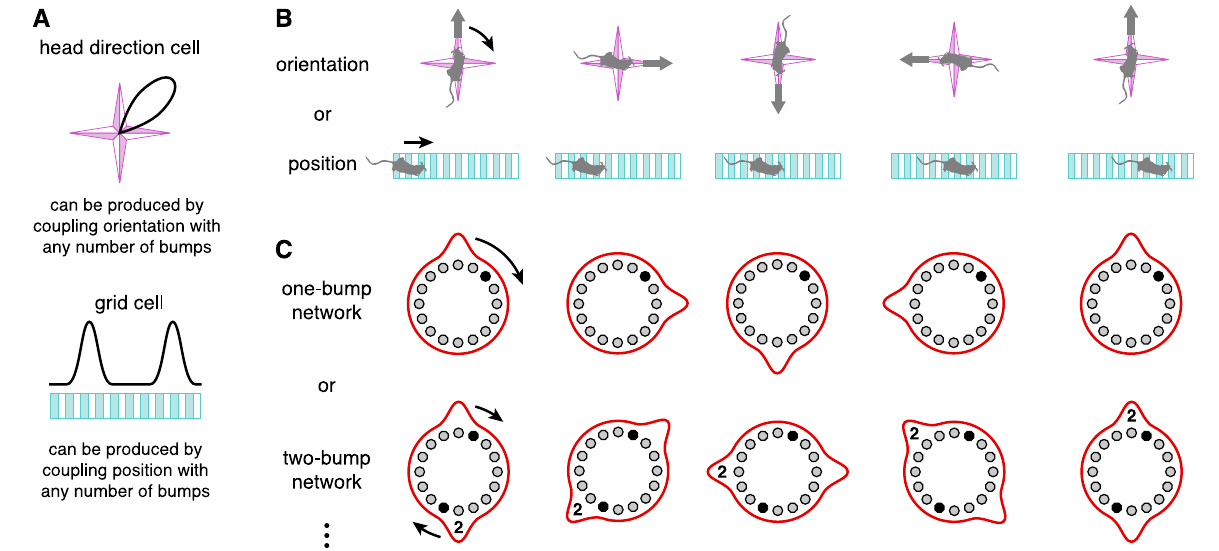
Fig 1. Continuous attractor networks with any number of bumps can produce head direction cells and grid cells. ( A ) Desired tuning curves of a head direction cell and a 1D grid cell. ( B ) Orientation and position coordinates whose changes drive bump motion. ( C ) One- and two-bump ring attractor networks. Each black neuron produces the desired tuning curves in A . In the two-bump network, the coupling to coordinate changes is half as strong, and the second bump is labeled for